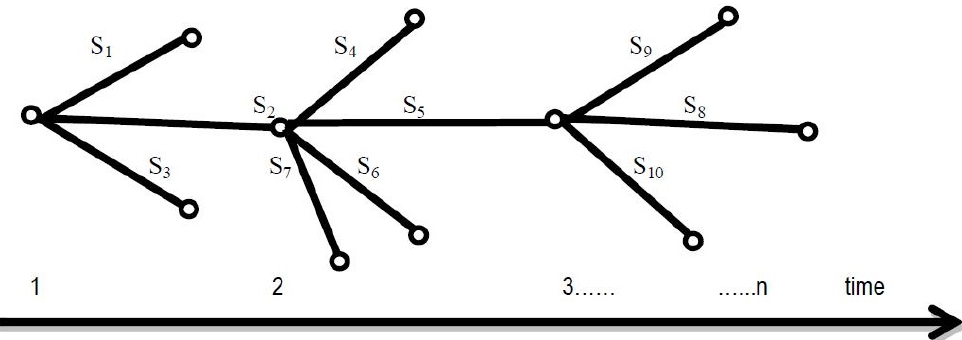
Figure 1. Decision tree probabilities and the adoption of new strategies.